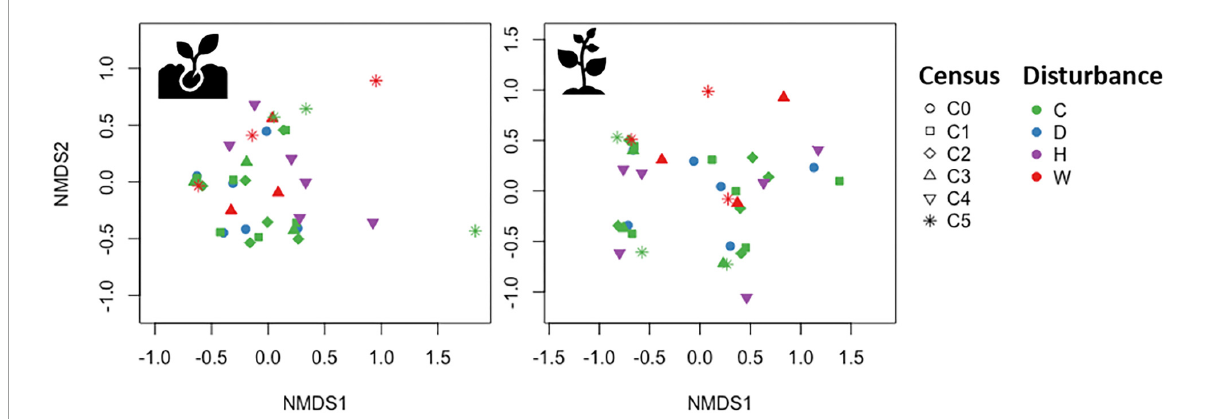
FIGURE3 Non-metric multidimensional scaling of seedling (Left) and sapling (Right) species composition. Each symbol represents the species composition in an experimental plot, during a specific census date (symbols; C0 = June 2015, C1 = November 2015, C2 = June 2016, C3 = June 2017, C4 = May 2018, C5 = April 2019) and disturbance type (colors; C = control, D = drought, H = hurricanes, W =